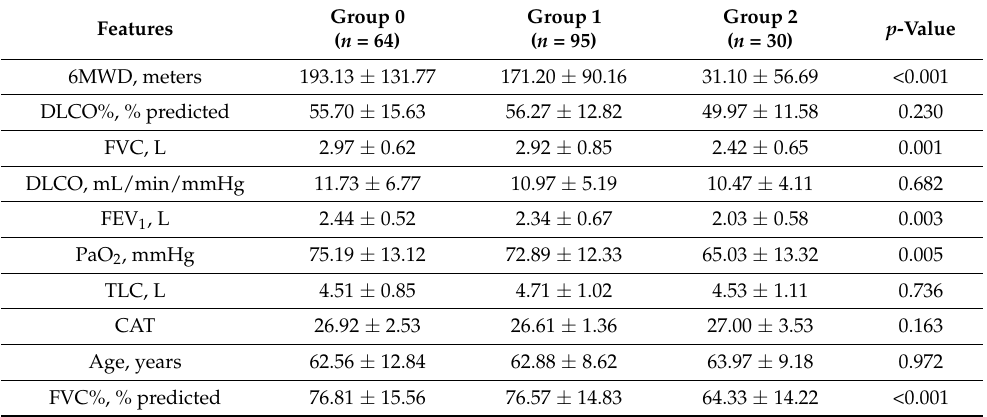
Table 5. Comparisons among the three classes of improvement following PR, according to the 10 most important